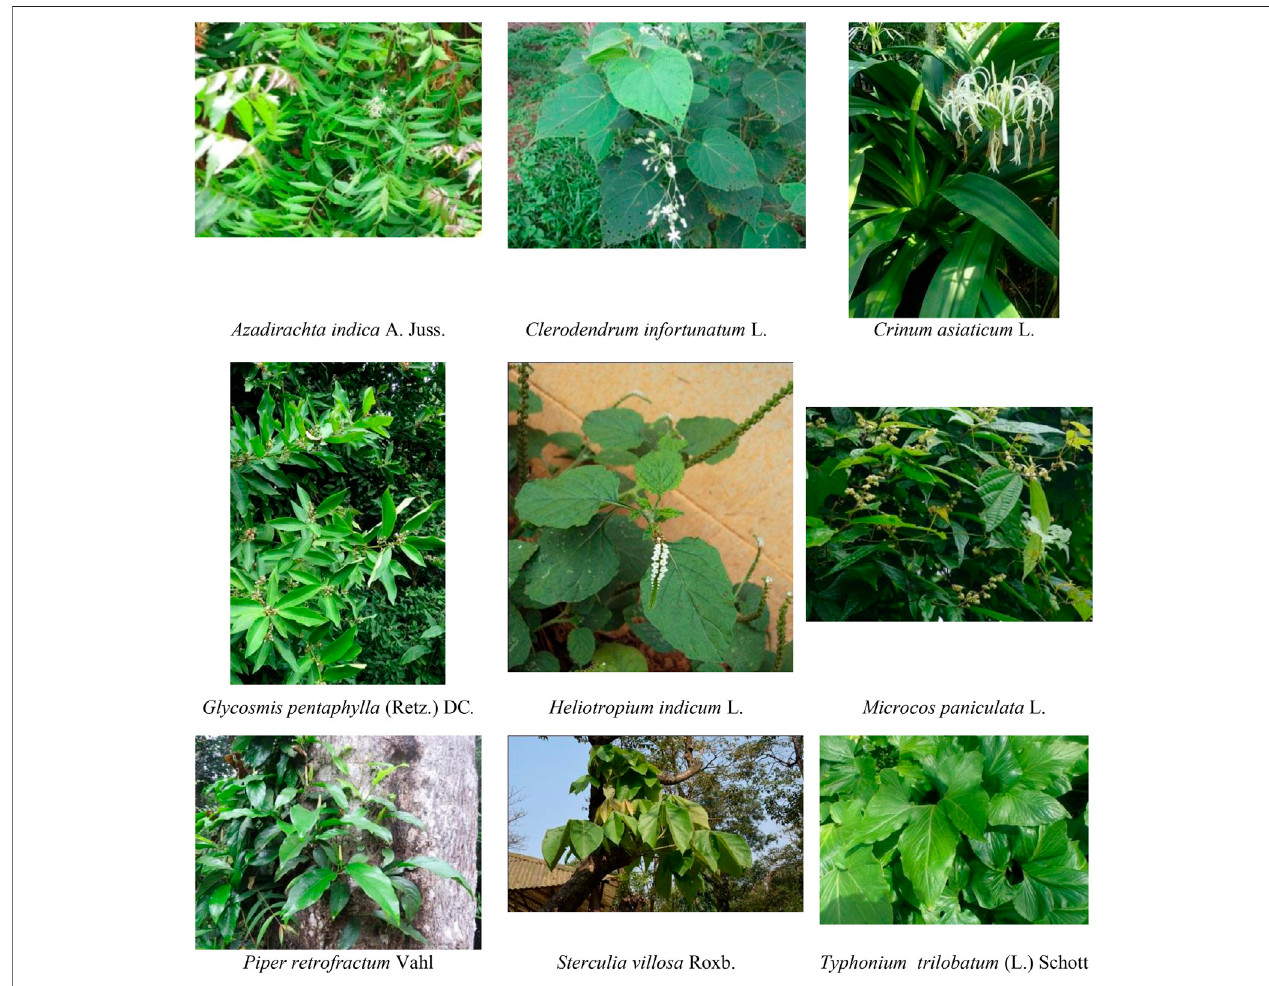
FIGURE 2 | Plants with anti-in fl ammatory activity, namely, A. indica , C. infortunatum , C. asiaticum , G. pentaphylla , H. indicum , M. paniculata, P. retrofractum , S. villosa , and T. trilobatum were obtained from Wikimedia Commons under GNU free documentation license (http://en.wikipedia.org/wiki/GNU_Free_Documentation_ License), whereas P. reticulatus was obtained from the web page “ Flora of Bangladesh, ” from the Survey of Vascular Flora of Chittagong and the Chittagong Hill Tracts Project, Bangladesh National Herbarium (http://bnh- fl ora.gov.bd), Ministry of Environment & Forest, People ’ s Republic of Bangladesh.